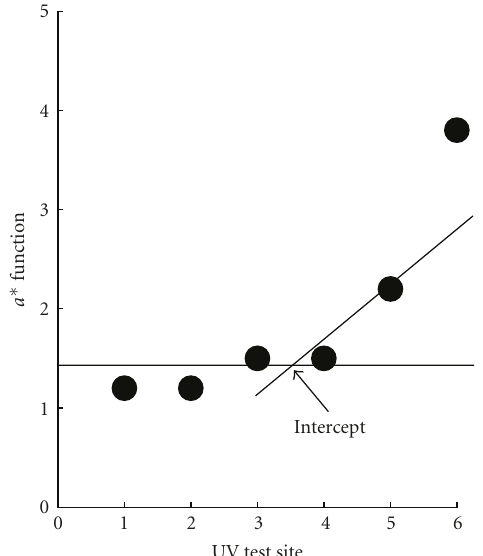
Figure 3: Colorimetric determination of MED with mathematical model.